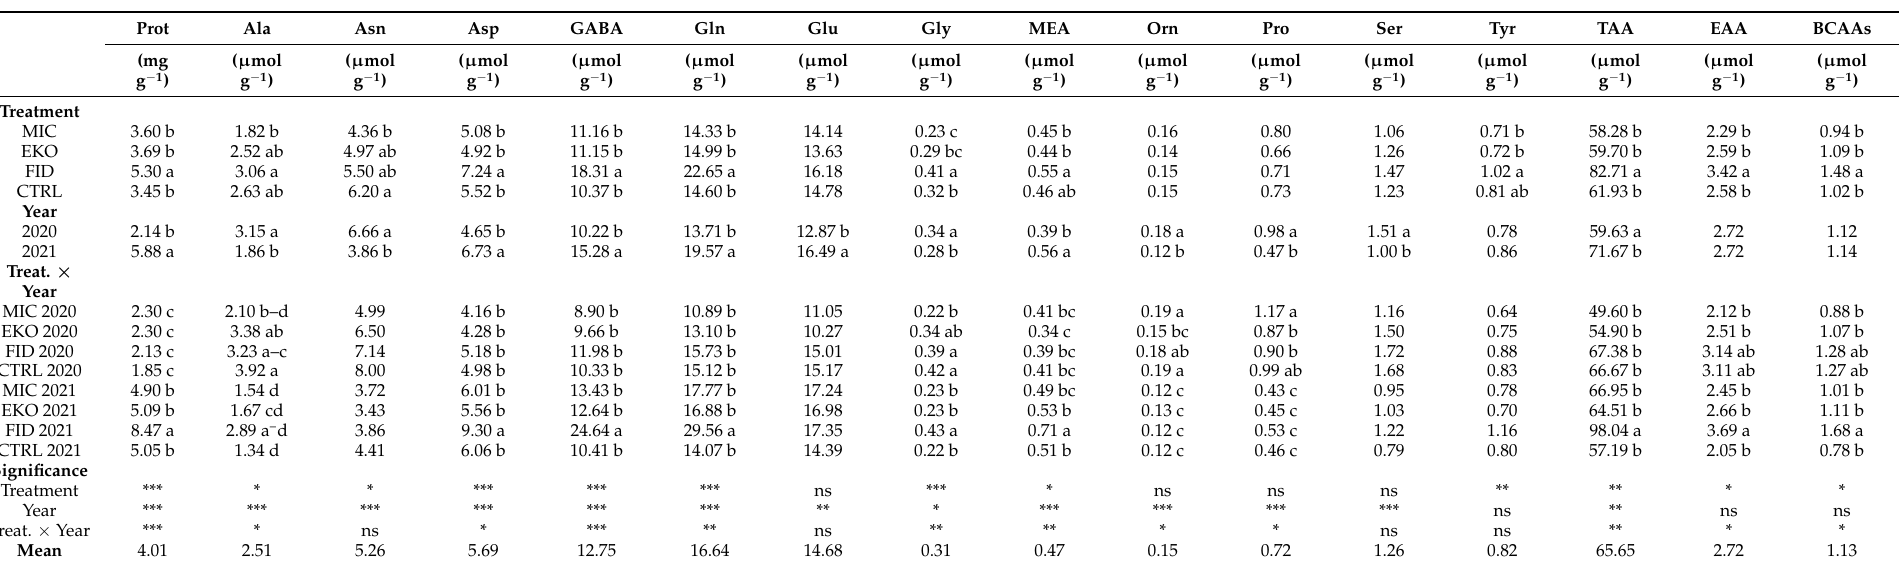
Table 3. Effects of treatments (MIC = Micosat F Tab Plus, EKO = EKOprop NX, FID = Fidelius, CTRL = control), year and treatment × year interaction on